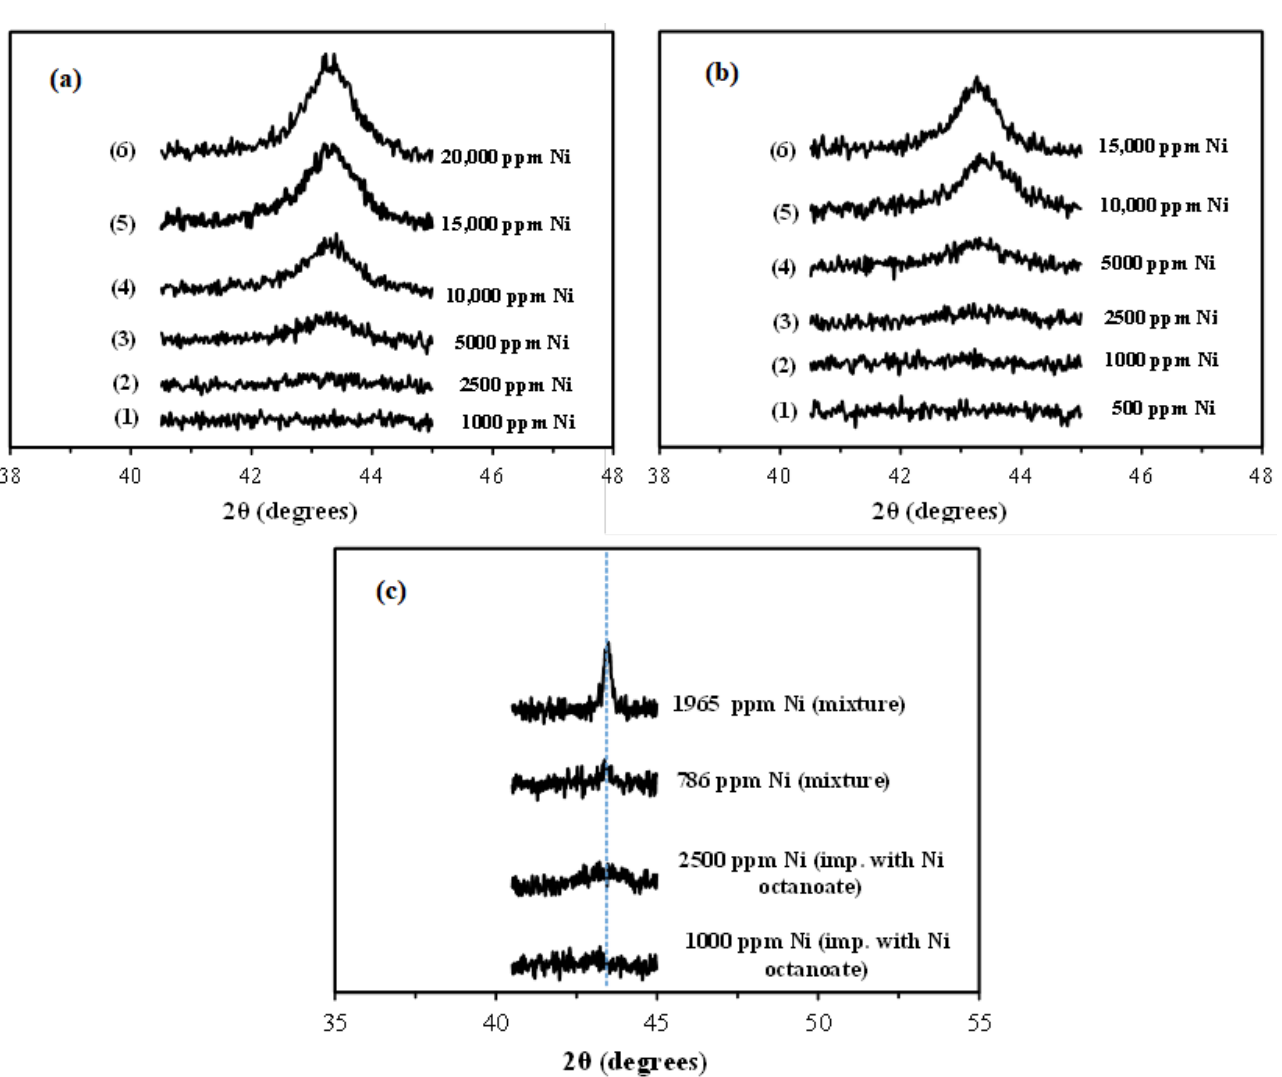
Figure 3. XRD patterns. ( a ) SiO 2 -Ni- X samples prepared via impregnation of SiO 2 with aqueous solutions of nickel nitrate; X : ( 1 ) 1000 ppm Ni, ( 2 ) 2500 ppm Ni, ( 3 ) 5000 ppm Ni, ( 4 ) 10,000 ppm Ni, ( 5 ) 15,000 ppm Ni, and ( 6 ) 20,000 ppm Ni. ( b ) SiO 2 -Ni-oc- X samples prepared via impregnation with Ni octanoate solution diluted in hexane (see experimental section); X : ( 1 ) 500 ppm Ni, ( 2 ) 1000 ppm Ni, ( 3 ) 2500 ppm Ni, ( 4 ) 5000 ppm Ni, ( 5 ) 10,000 ppm Ni, and ( 6 ) 15,000 ppm Ni. ( c ) SiO 2 -Ni-oc- X samples with 1000 and 2500 ppm Ni, and two physical mixtures of bulk NiO with SiO 2 at two levels of Ni content, i.e., 786 and 1965 ppm Ni (corresponding to 1000 and 2500 ppm NiO). The dashed line in the graphs represents the (2 0 0) reflection of NiO (bunsenite).